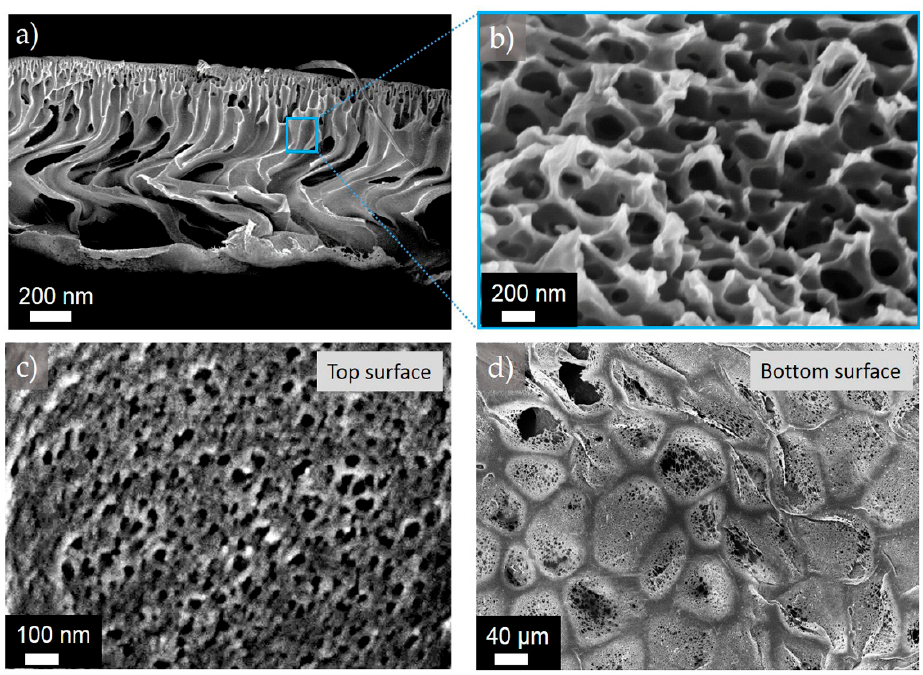
Figure 6. Representative SEM images obtained for the membrane M2-12: ( a ) and ( b ) cross-section at two different magnifications; ( c ) top and ( d ) bottom surface structure.